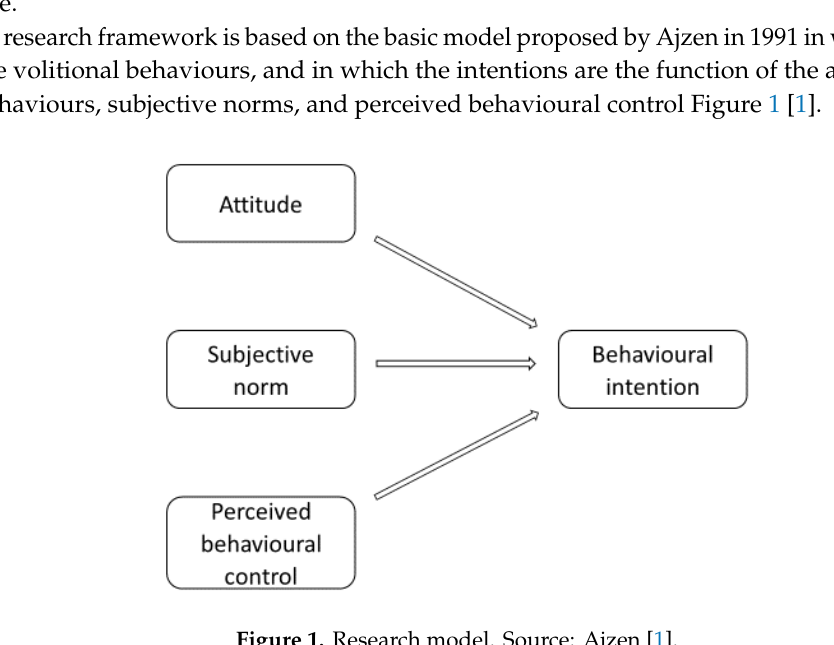
Figure 1. Research model. Source: Ajzen [1].